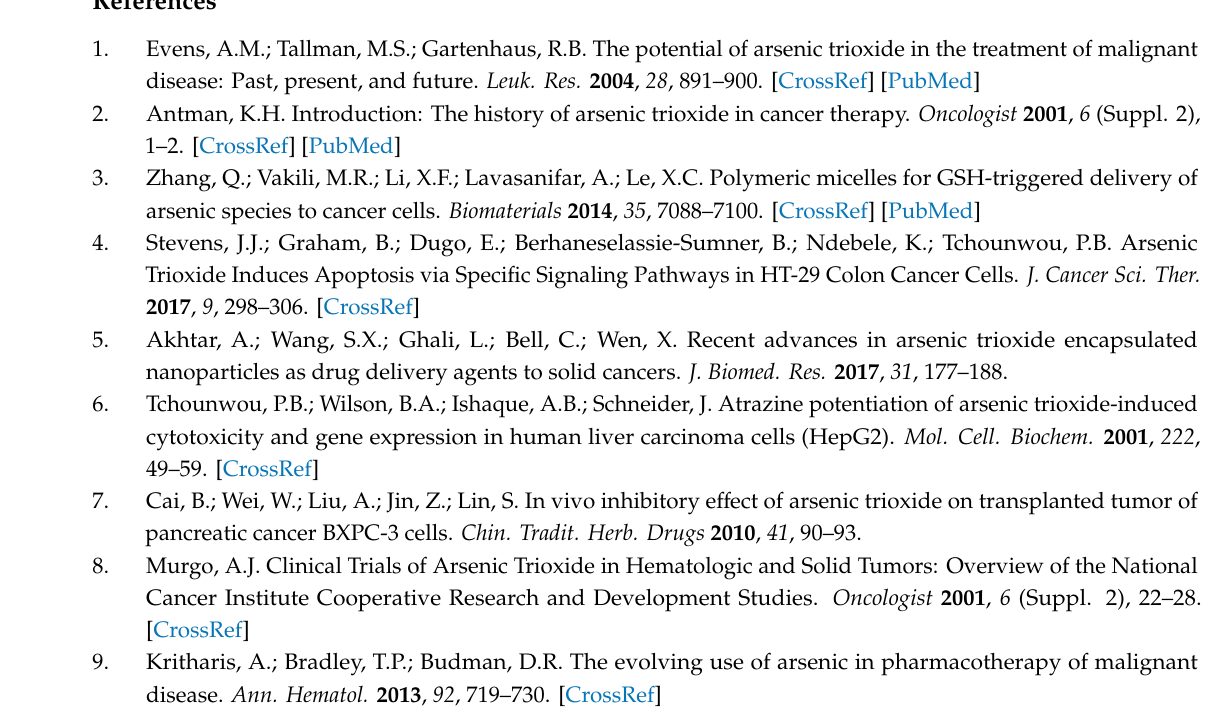
Table S1: Investigation of encapsulation e ffi ciency and drug loading